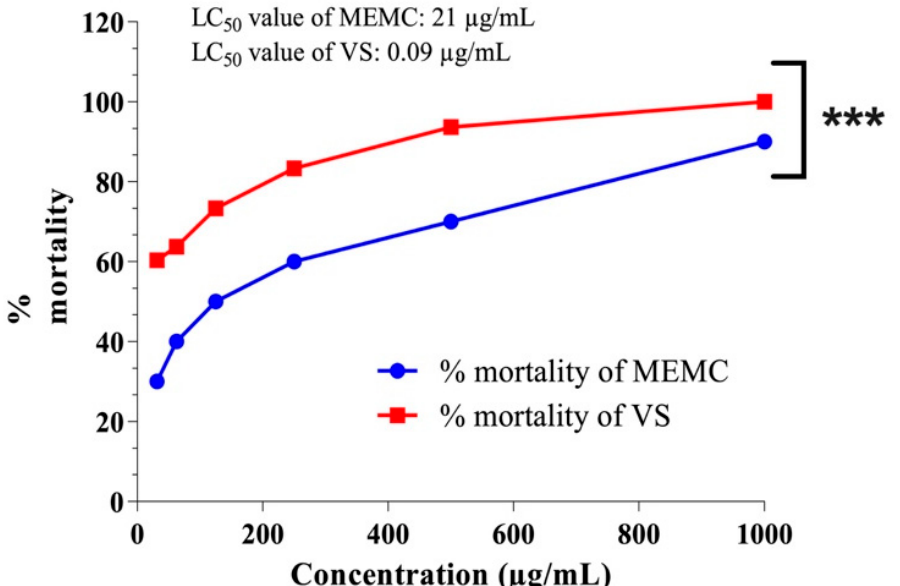
Figure 2. Determination of LC50 value of MEMC and VS (vincristine sulfate) from linear correlation between concentrations versus percentage of mortality. Values are expressed as mean ± SEM ( n = 3) where data were analyzed by two-way ANOVA (Sidak’s multiple comparison test) and *** p value less than 0.001 is considered as statistically significant. MEMC, methanol leaf extract of Molineria capitulata.